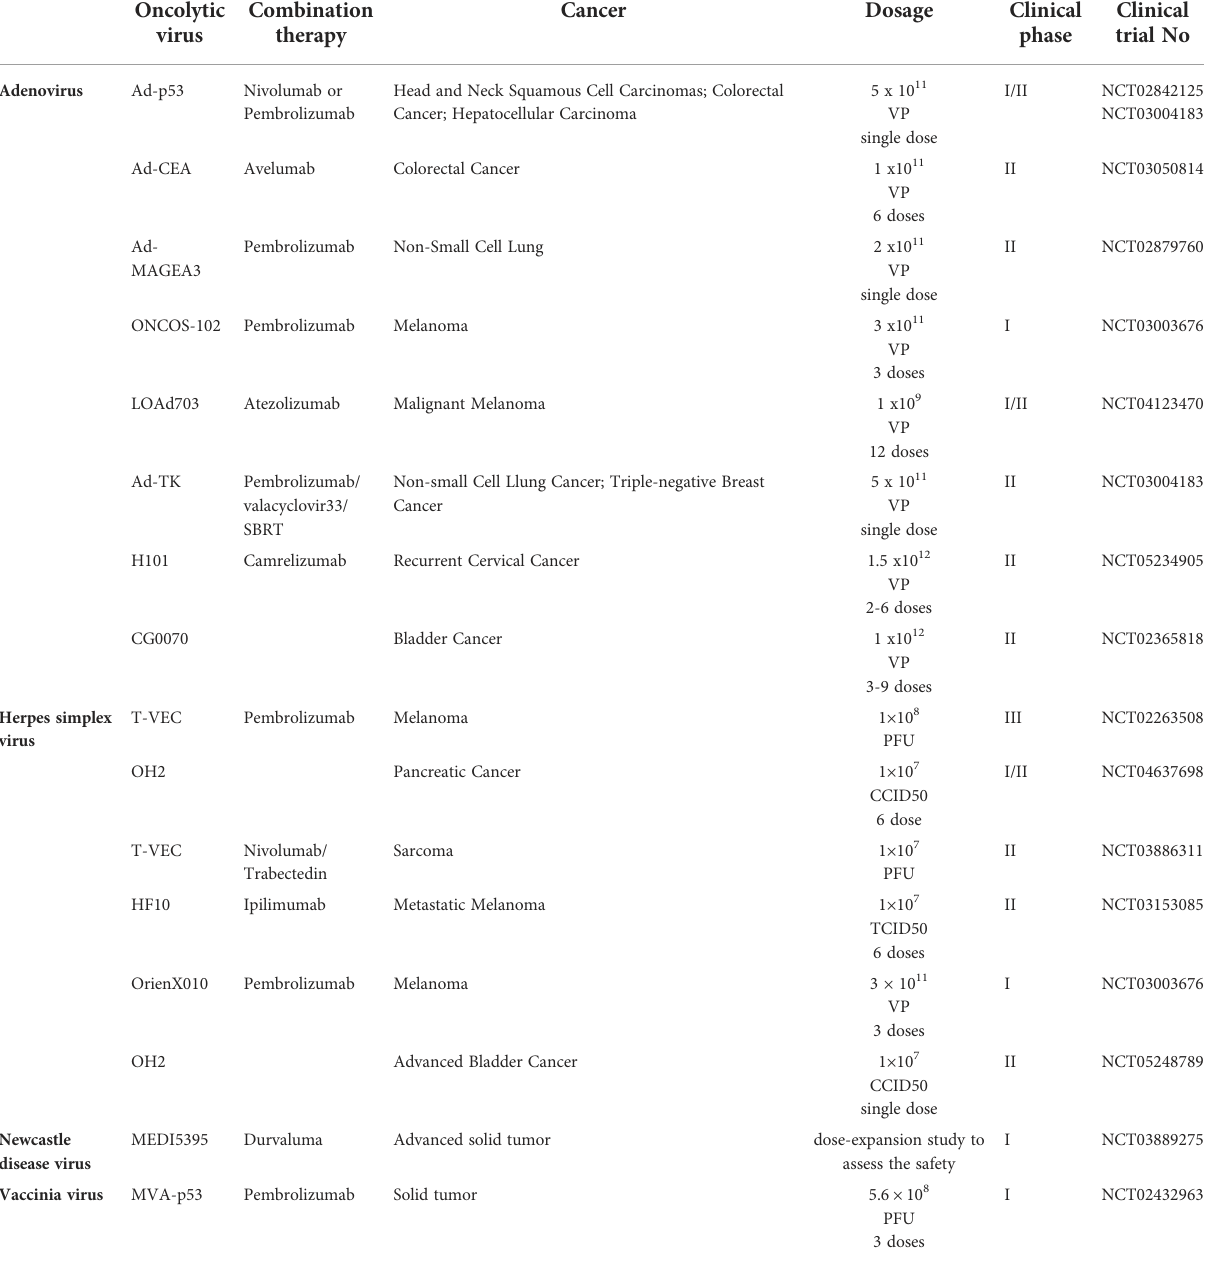
Cancer Dosage Clinical